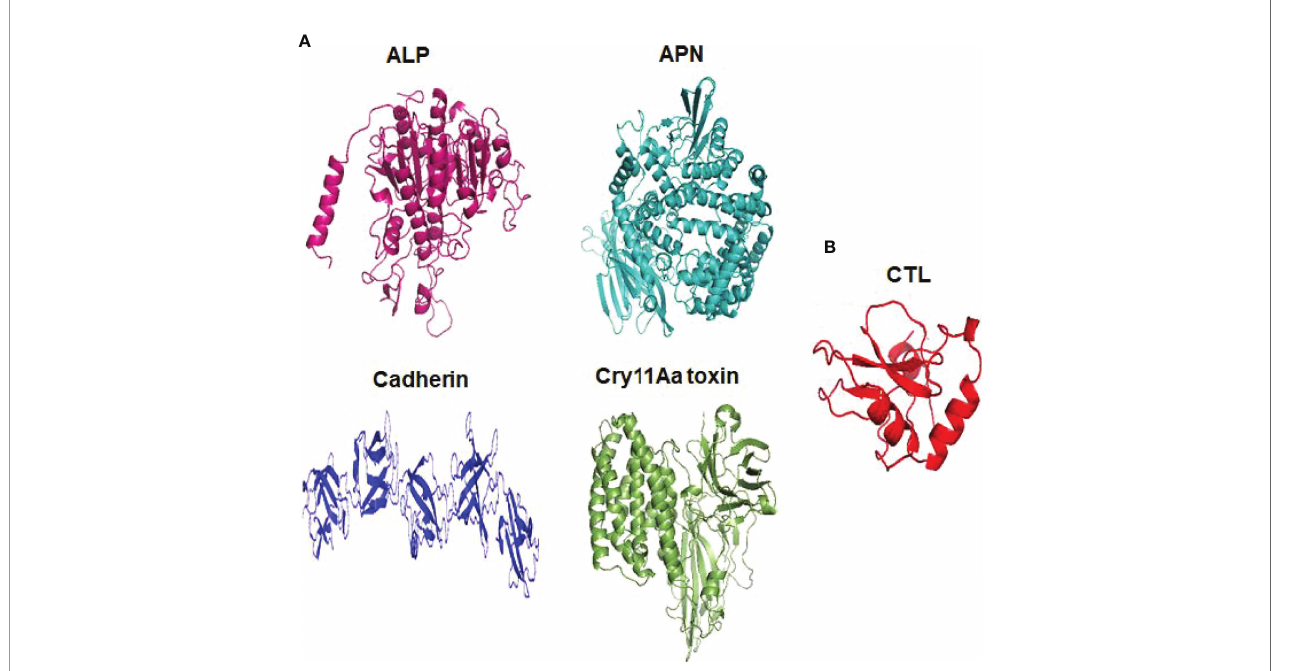
FIGURE 4 | Three dimensional structural presentation of putative receptors, toxin and CTL domain in Ae. aegypti . (A) ALP (PDB: IK7H), APN (PDB: 4WZ9), Cadherin (PDB: 4UX8), Cry11Aa toxin (PDB: 1DLC) and (B) CTL domain (PDB: 5E4L).